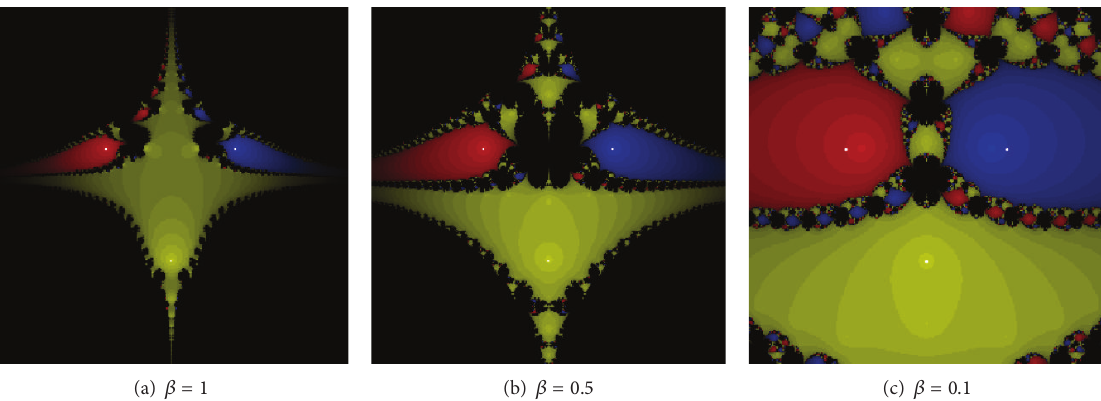
Figure 9: Scheme (3) for the test problem 5.